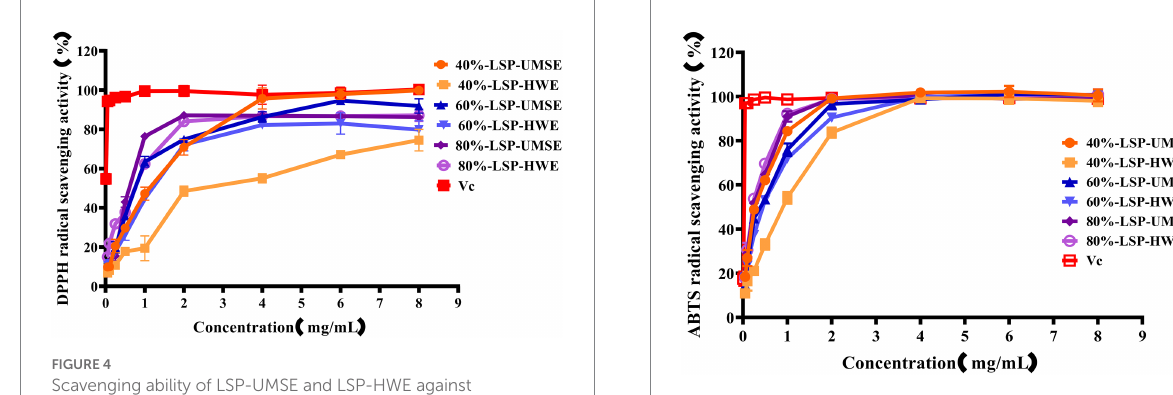
FIGURE 6 Scavenging ability of LSP-UMSE and LSP-HWE against ABTS radicals scavenging ability. Each value is expressed as mean ± SEM ( n = 3).